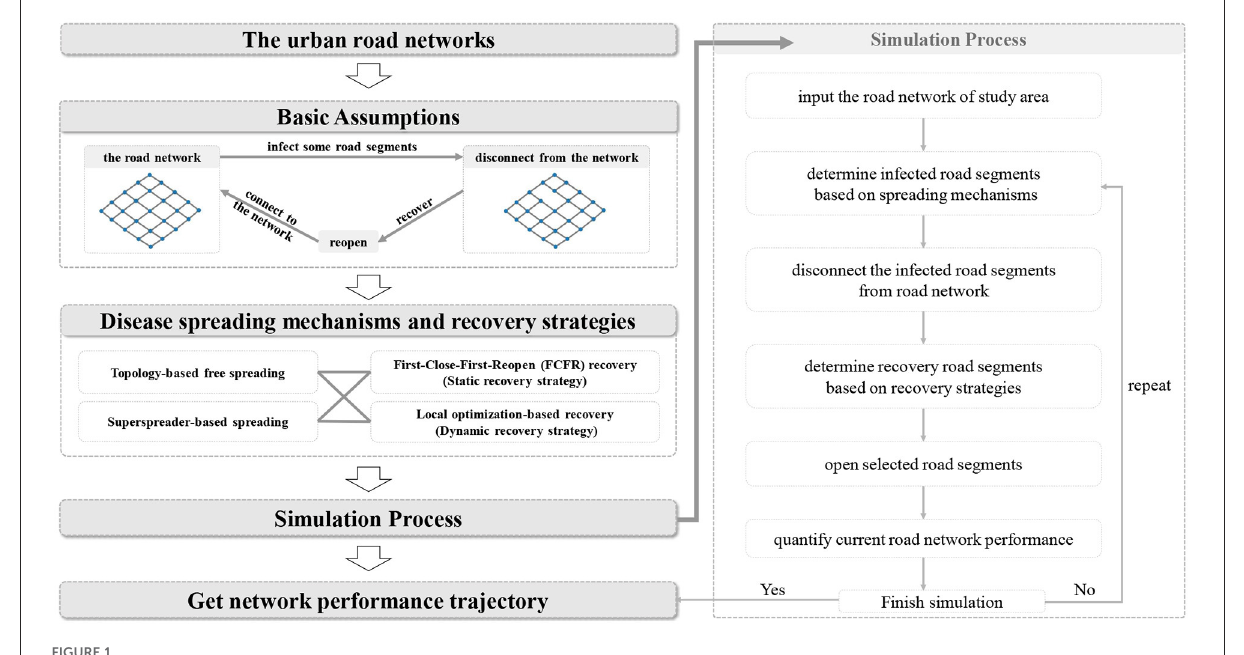
FIGURE1 The proposed simulation-based analytical